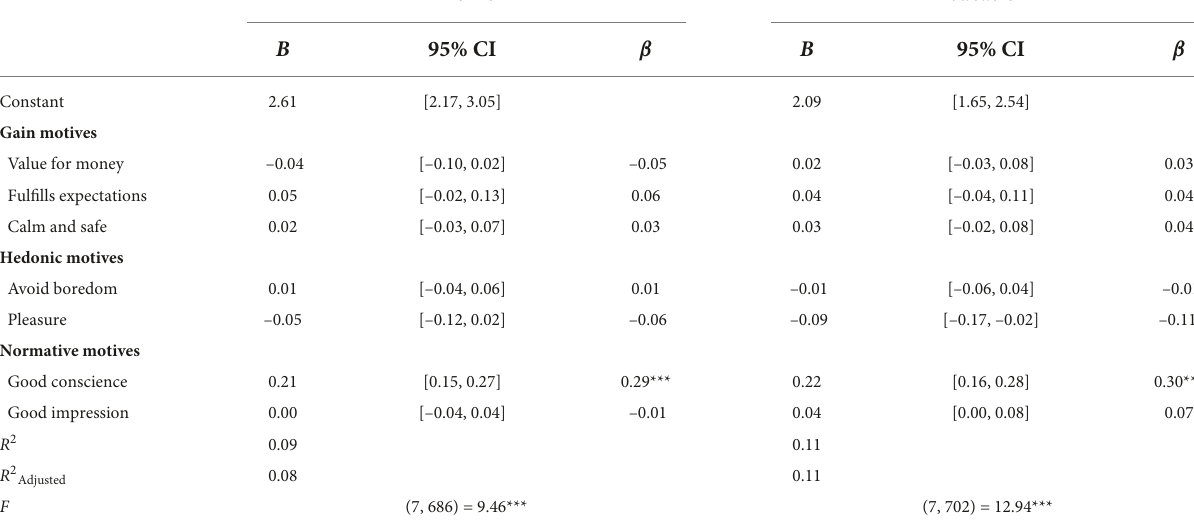
TABLE 3 Multiple regressions predicting purchasing intentions from consumption